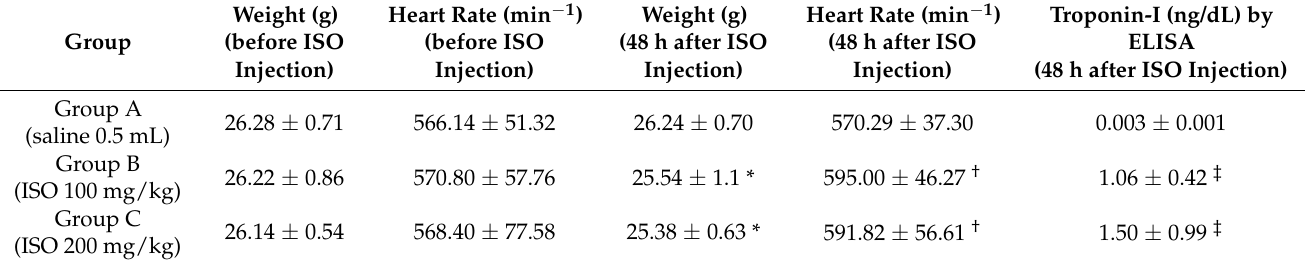
Table 1. Weight, heart rate, and cTnI measurements of the cardiac damage mouse model. All figures are expressed as Mean ± SEM, (N = 7 in control group and N = 5 in other groups), * p < 0.05 vs. weight before ISO injection, † p < 0.05 vs. heart rates before ISO injection, ‡ p < 0.05 vs. control group by standard clinical laboratory ELISA.